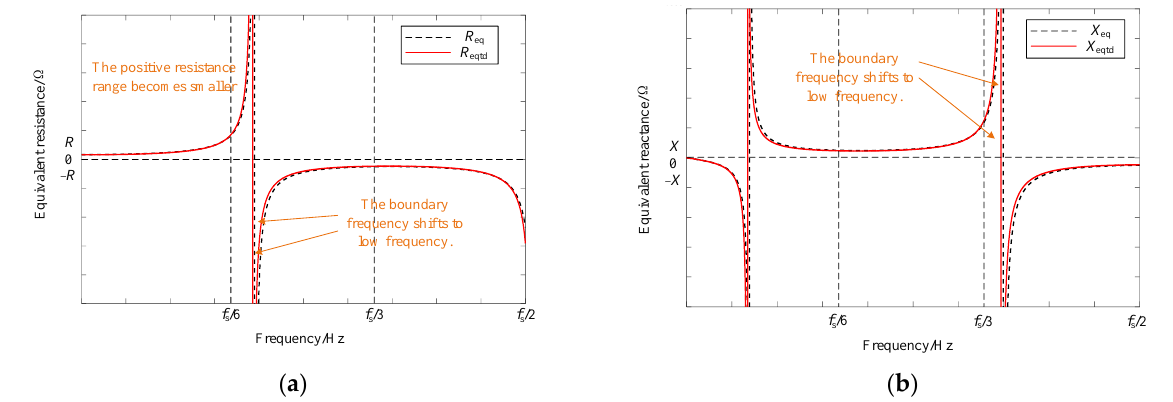
Figure 9. Frequency characteristics of virtual equivalent impedance. ( a ) Frequency characteristics of equivalent resistance R eq and R eqtd ; ( b ) Frequency characteristics of equivalent reactance X eq and X eqtd .